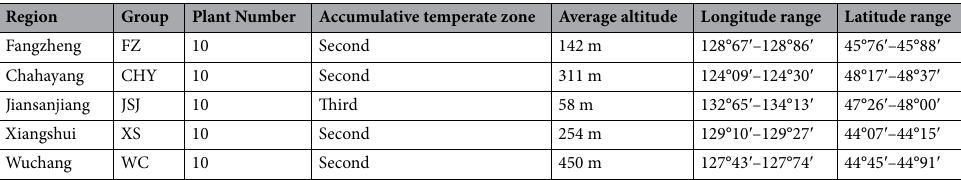
Table 6. Japonica sampling regions and their basic geographic information.